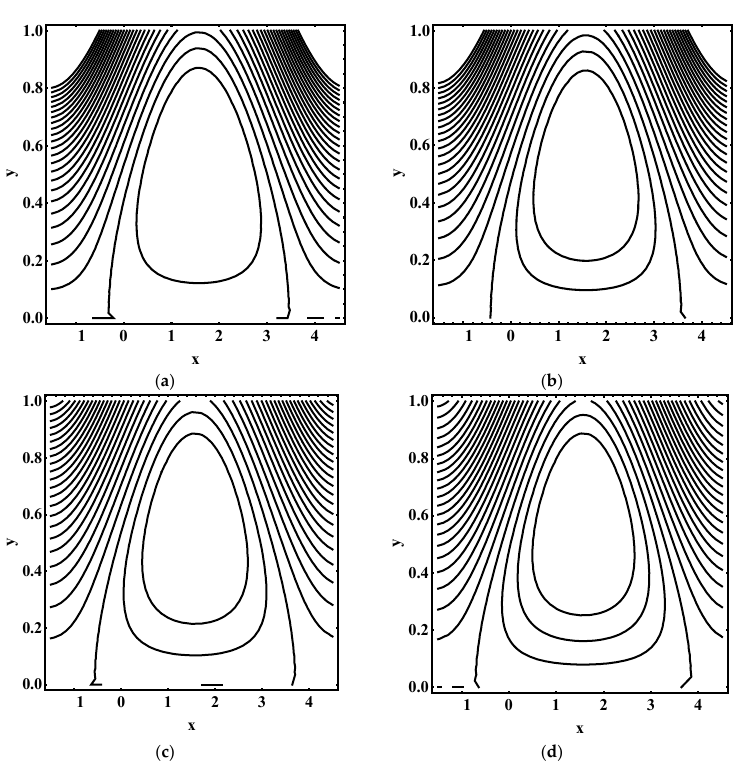
Figure 6. Streamline distribution for ( a ) . Г = 0.00 ( b ) . Г = 0.02 ( c ) . Г = 0.04 ( d ) . Г = 0.06, while other parameters are ε = 0.258, Θ = 0.8, m e = 2, U hs = − 1.